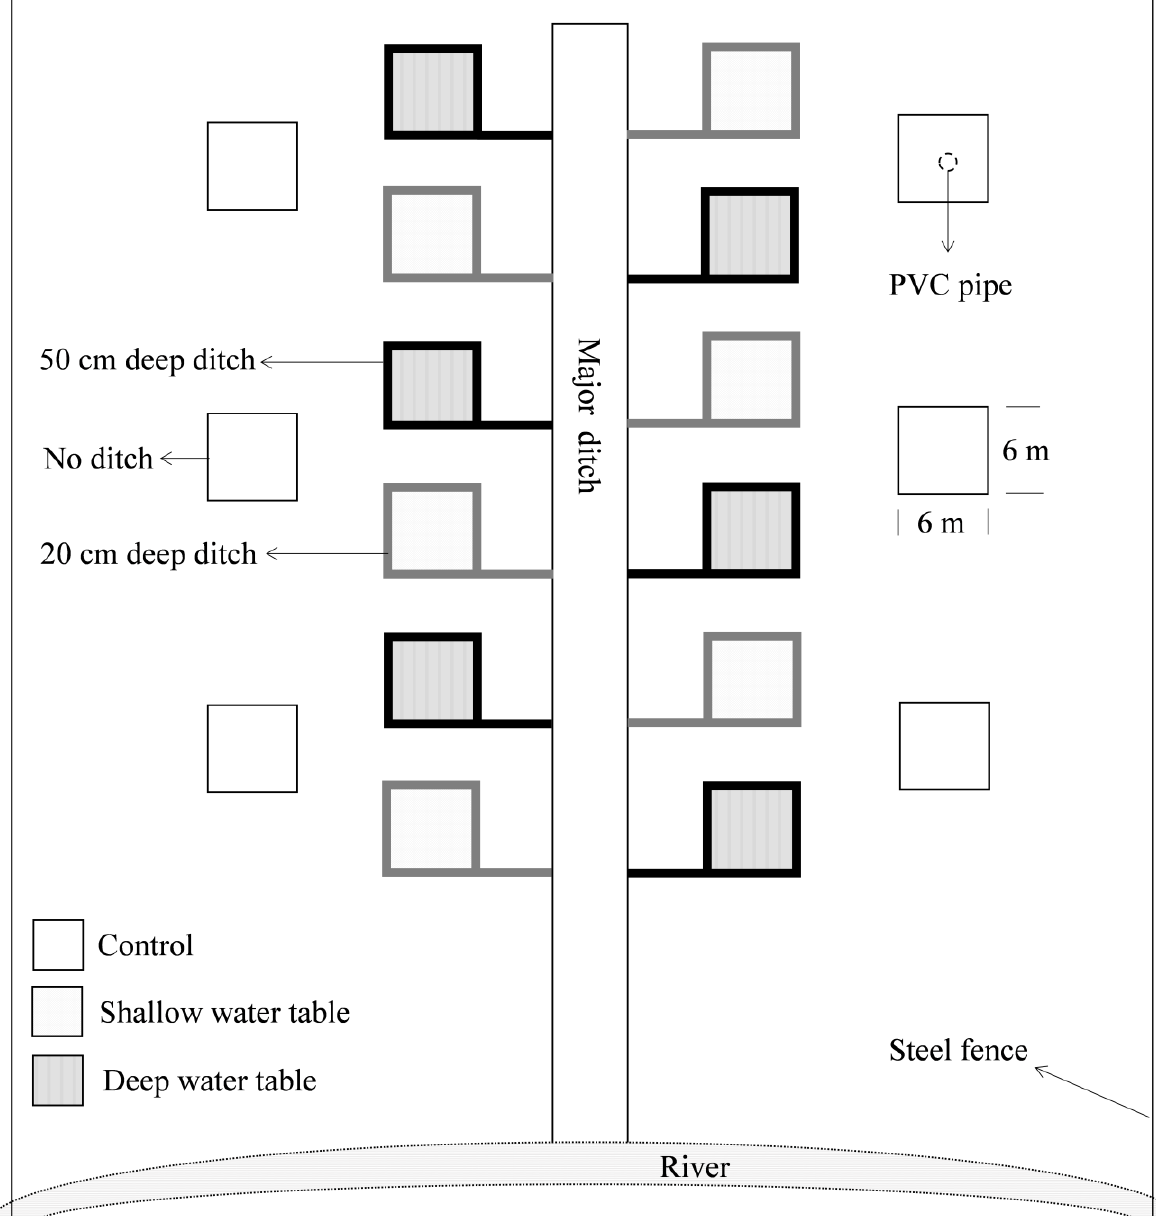
Figure 2. Diagram of the experimental design showing how the drainage treatments were deployed.